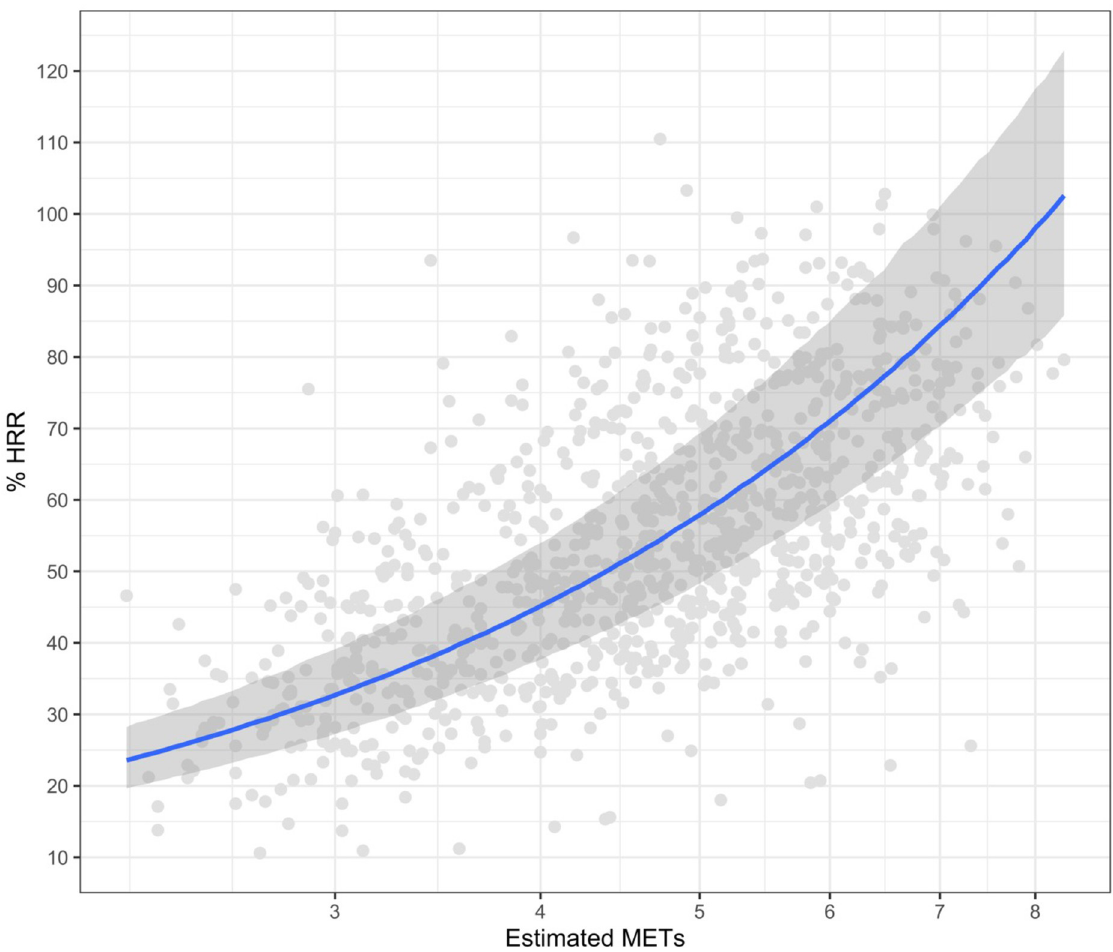
Fig 3. Bayesian random intercept logistic regression. The number of data points = 1257 due to each participant contributing multiple data points from multistage incremental tests. Please note that 5 data points for %HRR are above 100%, which is physiologically implausible. However, these are the data we obtained from the